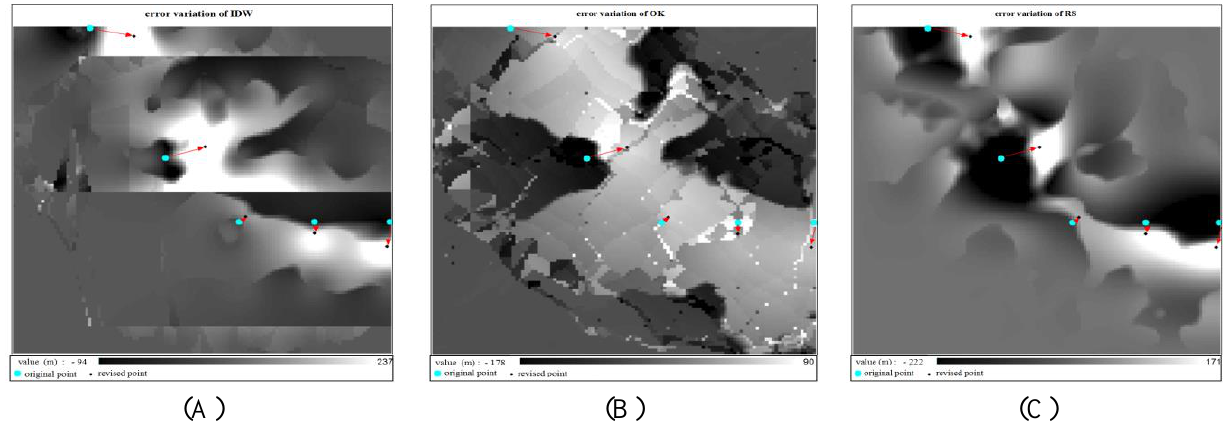
Figure 14. The variations of the errors at the sampling points of area A. ( A ) Error variations at the sampling points of IDW in area A; ( B ) Error variations at the sampling points of OK in area A; ( C ) Error variations at the sampling points of RS in area A.